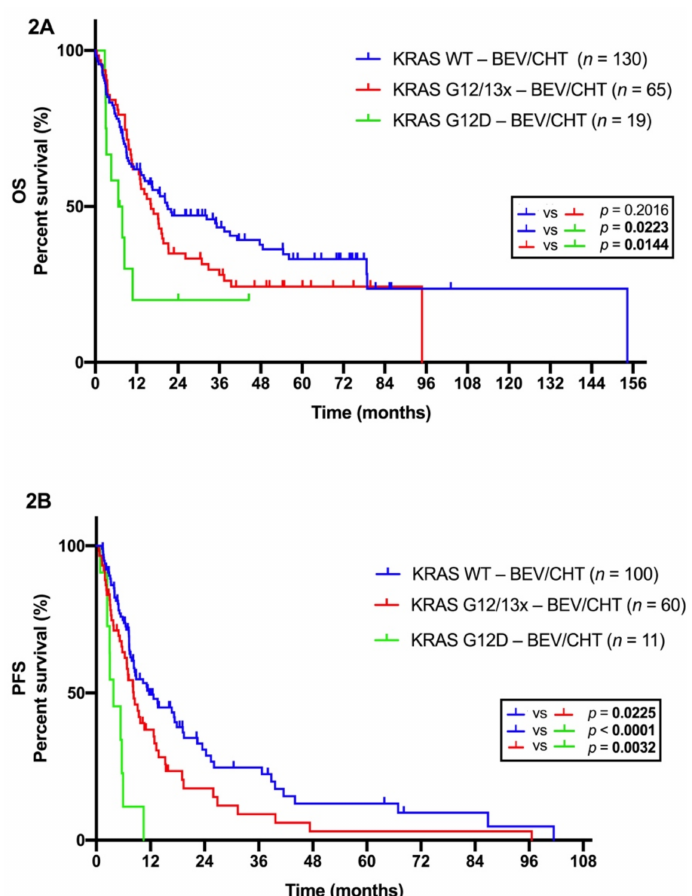
Figure 2. Kaplan-Meier plots for the OS ( A ) and PFS ( B ) in LADC patients receiving BEV / CHT according to subtype-specific codon 12 KRAS mutations. ( A ) KRAS G12D mutation was associated with significantly shorter OS in LADC patients (vs. KRAS G12x and 13x mutations or WT KRAS; median OSs were 7.2, 16.1, and 21 months, respectively, p values were 0.0144 and 0.0223, respectively, log-rank test). ( B ) LADC patients with tumors harboring KRAS G12D mutations had also significantly shorter median PFS than those with other codon 12 (G12x) and 13 (G13x) KRAS-mutant or with KRAS WT tumors (median PFSs were 3.7, 8.27, and 11.7 months, respectively; p values were 0.0032 and < 0.0001, respectively; log-rank